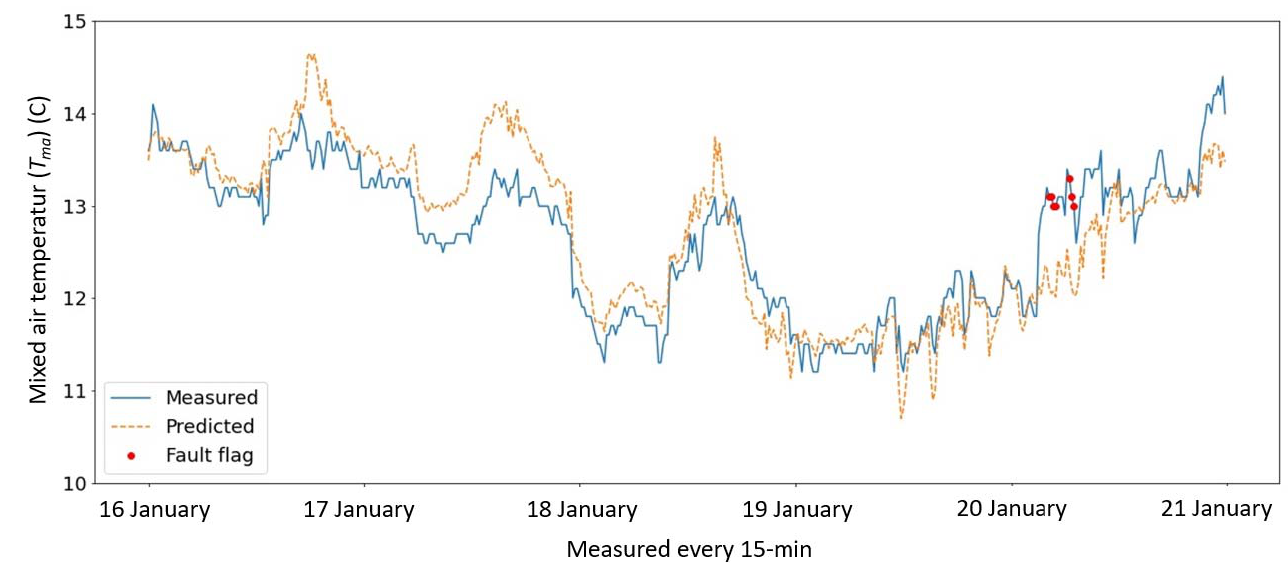
Figure 8. Measurements versus predictions of T ma over testing data set under normal operation conditions.